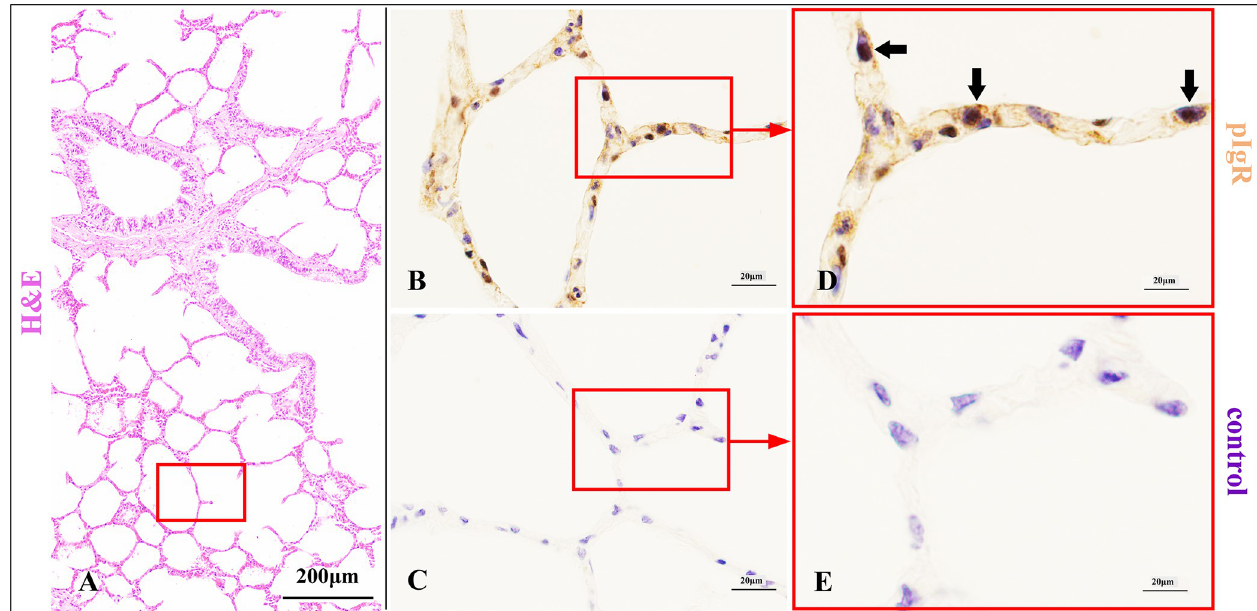
Fig 7. pIgR expression characteristics of pulmonary alveoli epithelium in Bactrian